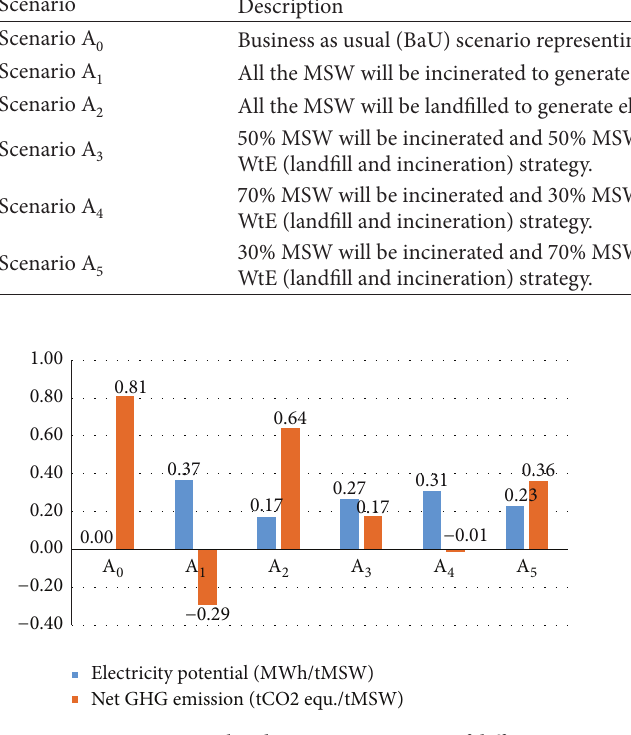
Figure 8: Energy potential and net GHG emissions of different WtE scenarios in Dhaka and Chittagong city,